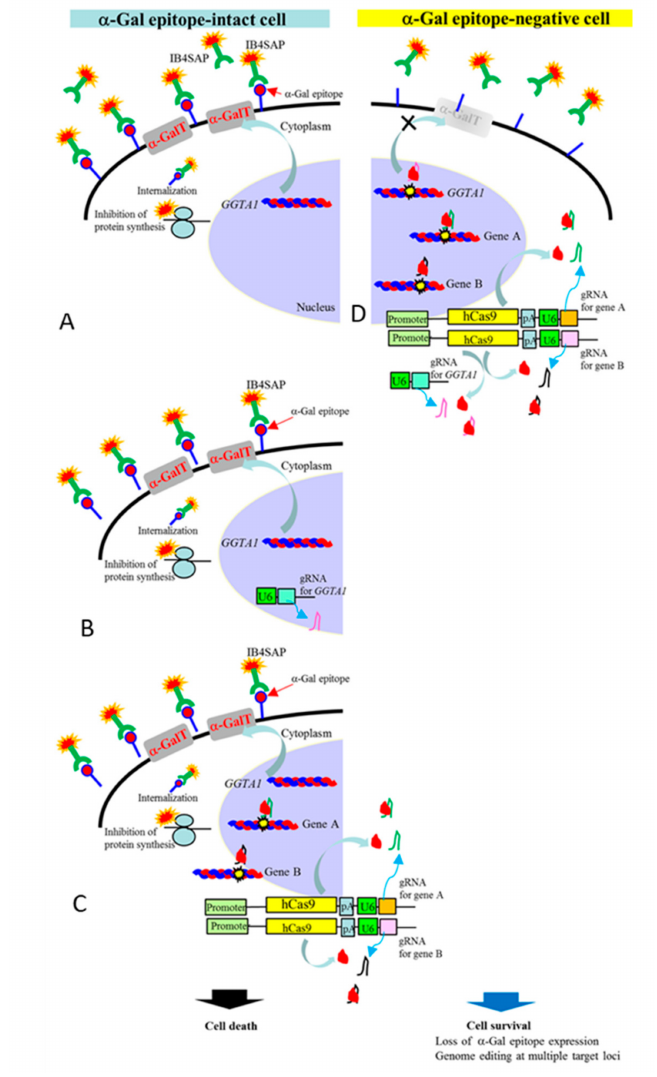
Figure 1. Schematic representation of the enrichment of genome-edited cells using CRISPR/Cas9-based genome editing and targeted toxin technology. Cells were transfected with two pCGsap1-based vectors conferring the expression of both hCas9 and sgRNA (targeted to gene A or B) along with pgRNA#3 vector conferring the expression of sgRNA for GGTA1 . After 4 days, cells were treated with IB4SAP for a short period. As shown in ( D ), only cells with ablated expression of cell surface α -Gal epitope, due to the disruption in the expression of GGTA1 that encodes α -GalT, would survive. IB4SAP is known to bind to α -Gal epitope-expressing cells, leading to their death. In these cells, hCas9 from pCGsap1-based vectors and sgRNA targeted to GGTA1 will be co-expressed, as α -GalT expression has been completely blocked by mutations in GGTA1 . At the same time, the expression of sgRNAs targeted to genes A and B may occur, leading to the induction of mutations at both loci. However, untransfected cells (shown in ( A )), cells expressing sgRNA for GGTA1 (shown in ( B )) and cells expressing sgRNA for gene A and B (but not GGTA1 ) as well as hCas9 (shown in ( C )) would undergo cell death, as these cells continue to express α -Gal epitope on their surfaces. U6, U6 promoter; hCas9, humanized Cas9 gene; pA, poly(A)